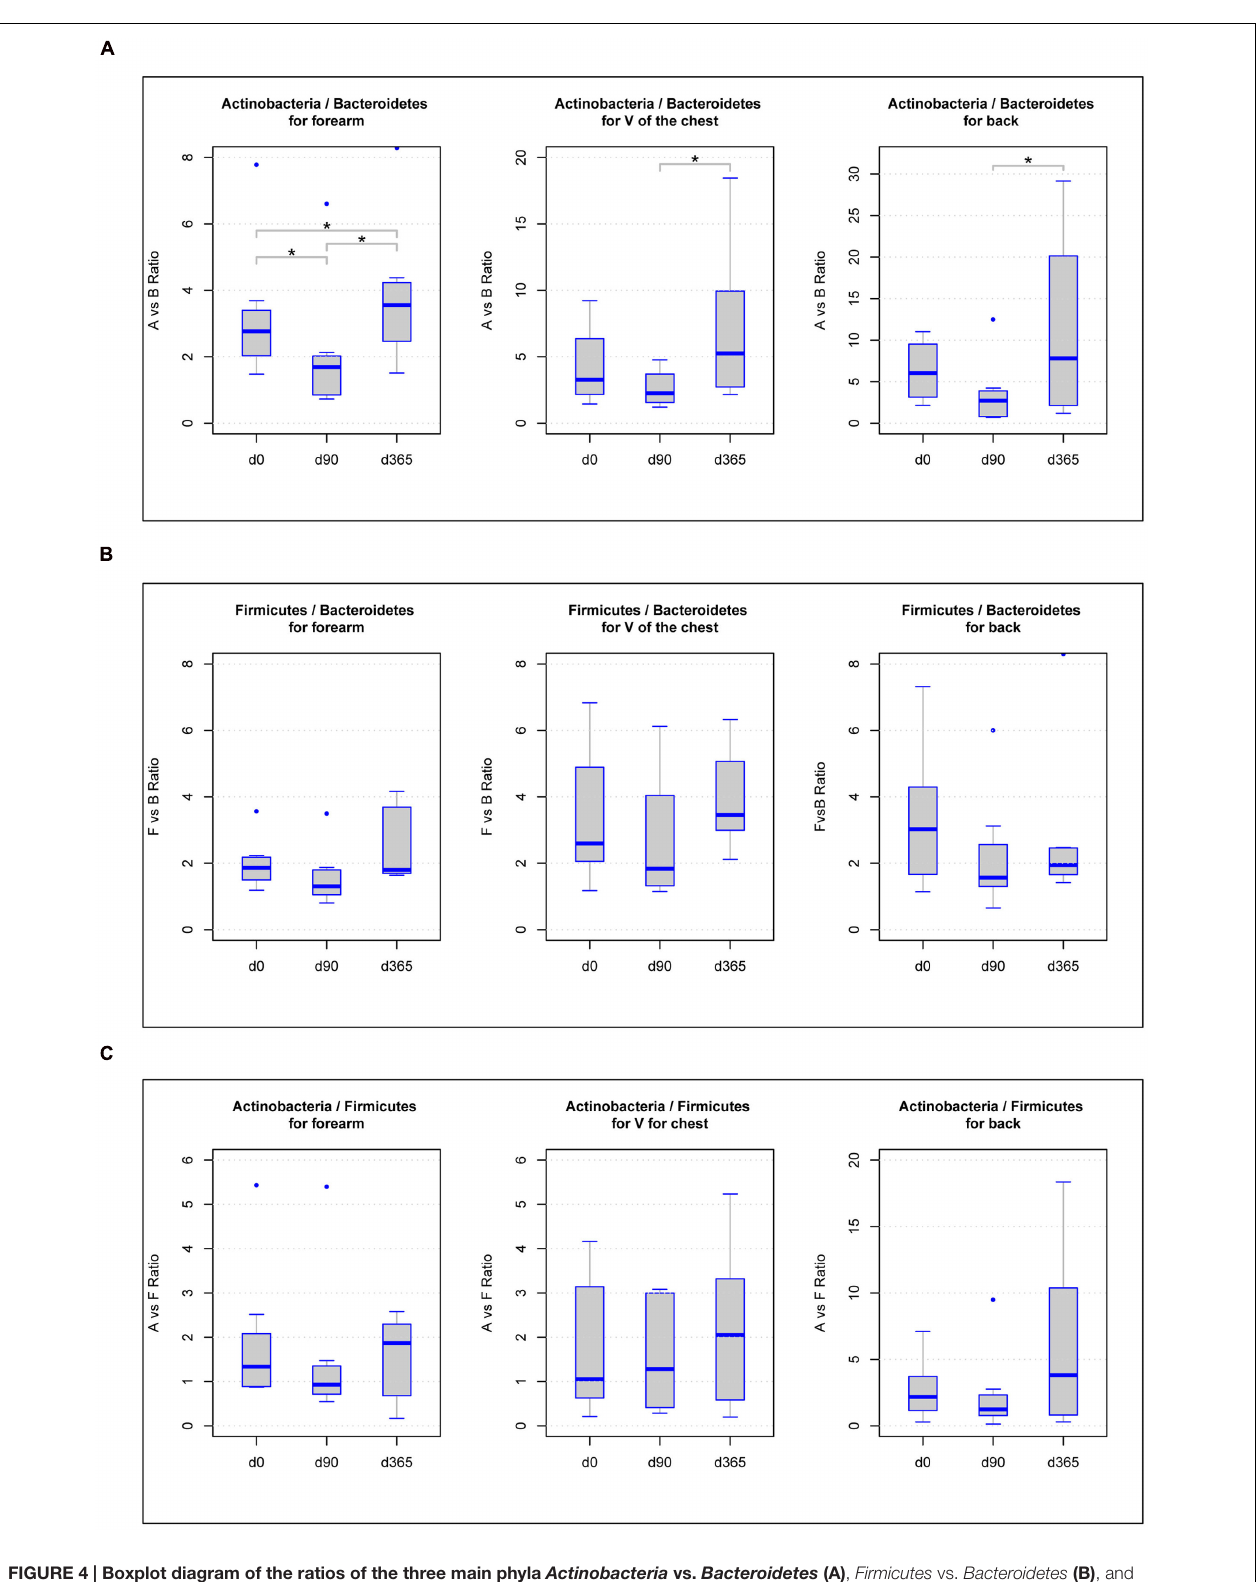
FIGURE 4 | Boxplot diagram of the ratios of the three main phyla Actinobacteria vs. Bacteroidetes (A) , Firmicutes vs. Bacteroidetes (B) , and Actinobacteria vs. Firmicutes (C) in forearm, V of the chest and back samples: significant differences in the phyla ratios between storage periods at − 80 ◦ C ( p -value below 0.05) are marked with a line between the affected sample groups and an